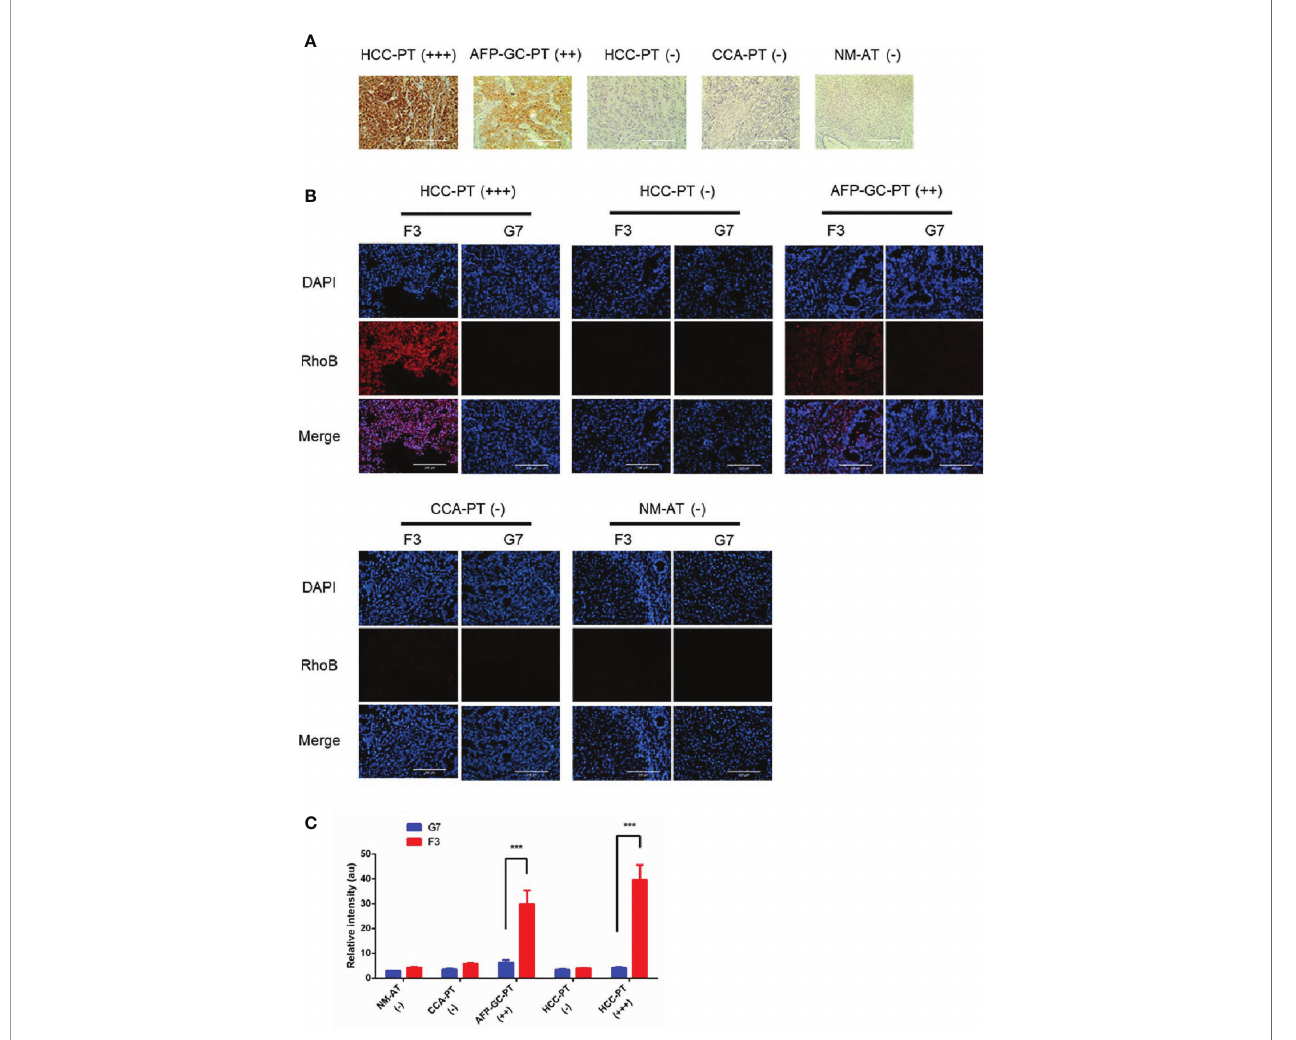
FIGURE 6 | Detection of GPC-3 in clinical samples ex vivo with RhoB-F3 peptide. (A) Immunohistochemical staining of GPC-3 in human tissues with anti-GPC-3 antibody. Expression levels of GPC-3 were evaluated as ( – ), (++), and (+++). Scale bars: 200 µm. (B) Fluorescent staining with RhoB labeling peptides (red) in sections. Strong binding of RhoB-F3 to AFP-GC-PT (++) and HCC-PT (+++) was noticed. Nuclei were stained with DAPI (blue). Scale bars: 200 µm. (C) Quanti fi cation of RhoB fl uorescence using Image J. F3 peptide showed great af fi nity to AFP-GC-PT and HCC-PT relative to G7 peptide (n = 5 per group, F3 to G7 in HCC-PT (+++), p =0.0002, ***p < 0.001, two-tailed Student ’ s t-test) (n = 5 per group, F3 to G7 in AFP-GC-PT, p =0.0001, ***p < 0.001, two-tailed Student ’ s t-test). All data represent the means ± standard error. P-value was calculated by two-tailed Student ’ s